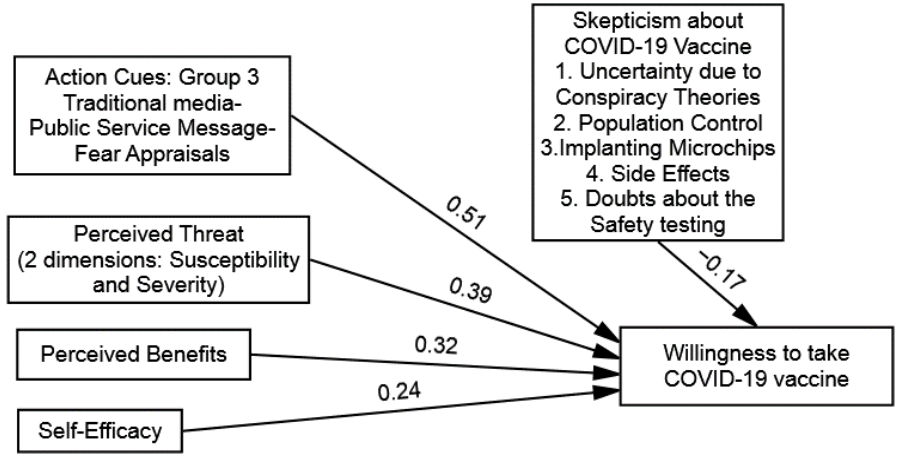
Figure 4. Structural model of group 3: Traditional Media–Public Service Message–Fear Appraisals .